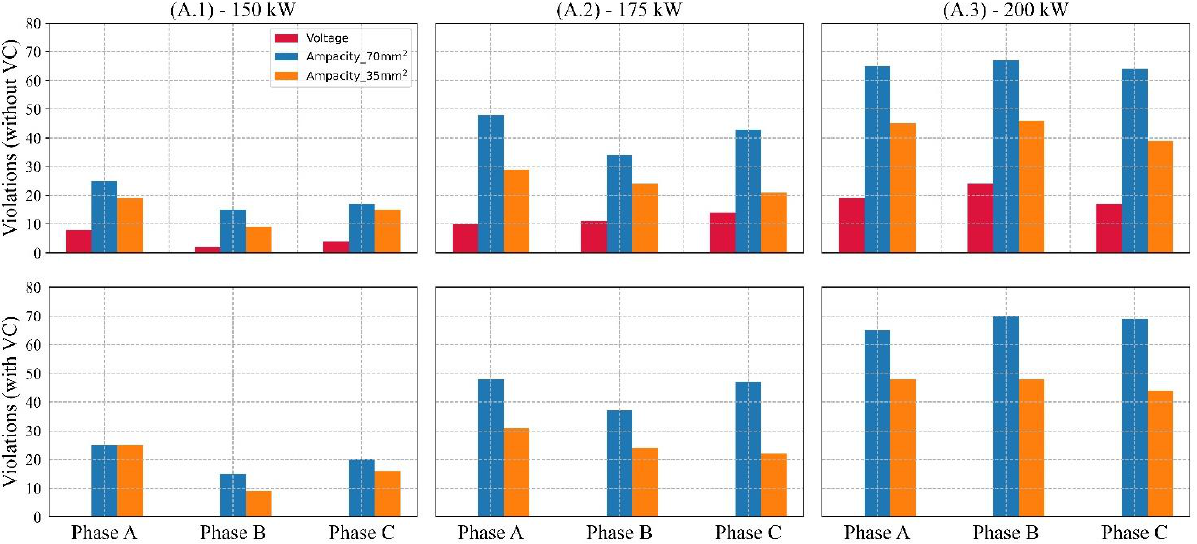
Figure 6. Number of voltage and ampacity (i.e., SLR) violations occurred for (A.1) — 150 kW, (A.2) — 175 kW, and (A.3) — 200 kW total installed capacities.